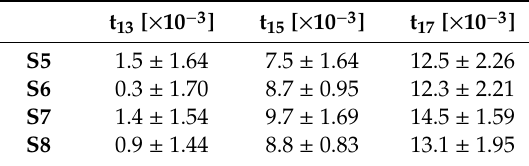
Figure 5. Pressure at an outlet feeding the tumor. The S7 (which includes tumor) total resistance was 6.8 × 10 4 dyne·s/cm 5 . Red arrow shows how the peak pressure time shifted by increasing R d / R p . The pressure waveforms moved in vertical direction for a better illustration. Table 2. The pressure waveform time lag (mean ± SD) between the cases with R d / R p = 1 and 3 (t 13 ), 1 and 5 (t 15 ), and 1 and 7 (t 17 ).